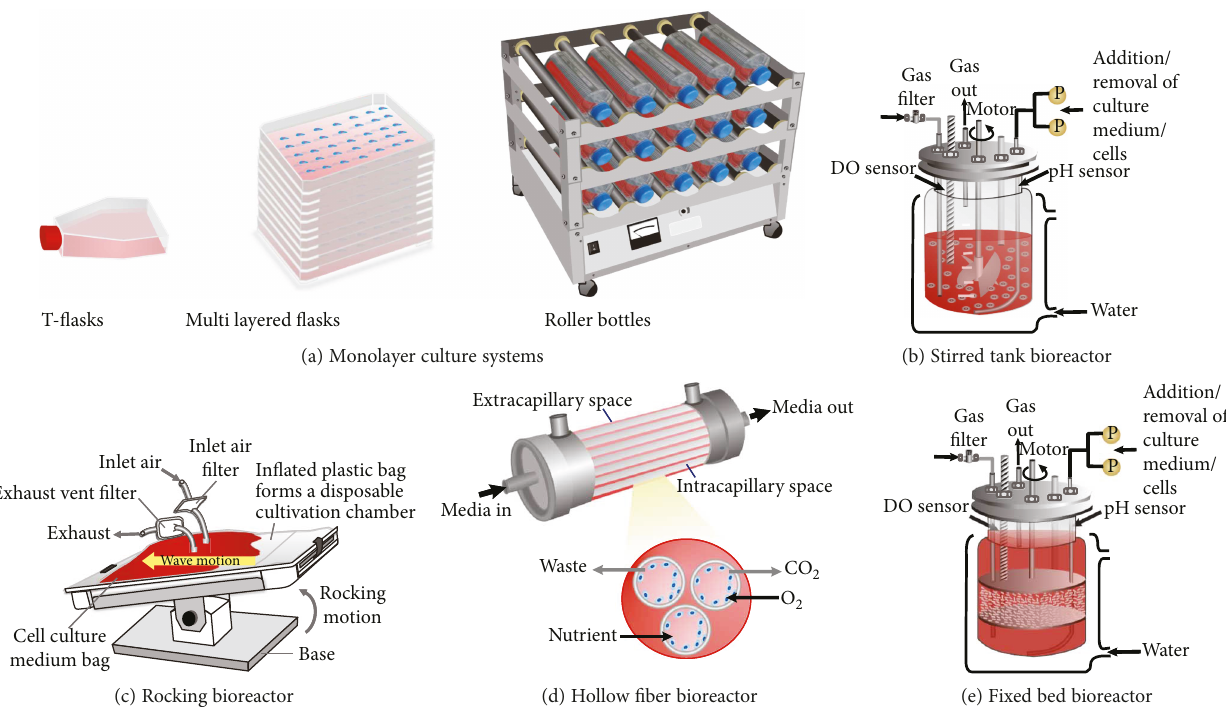
Figure 2: Schematic representation of monolayer culture systems and bioreactors used for MSC